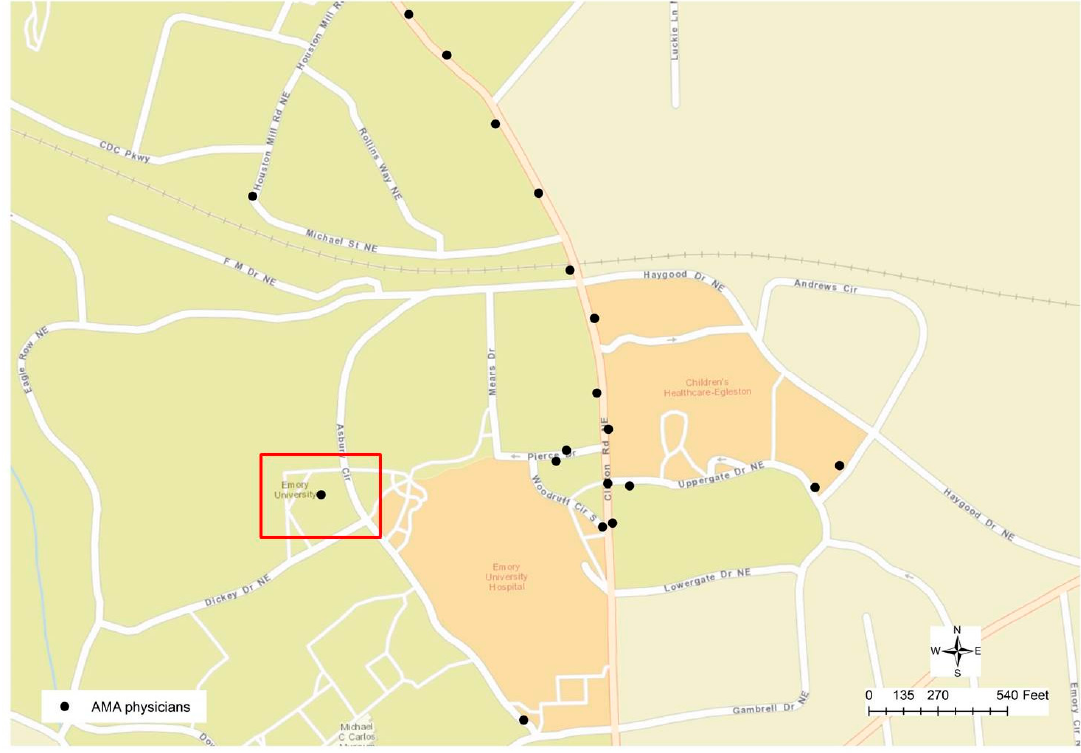
Figure 4. Errors in the geocoding results.